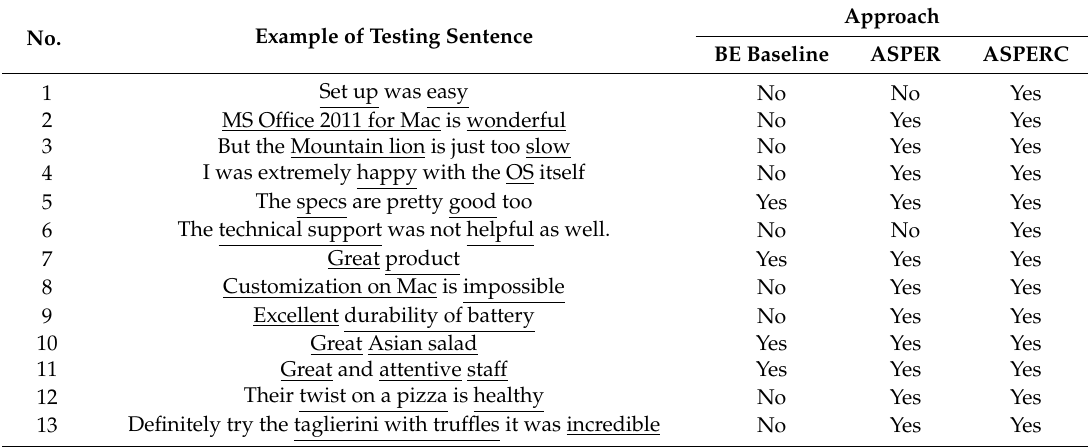
Table 13. Comparison of aspect-sentiment pair extraction ASPER model, ASPERC model, and BE baseline. No. Example of Testing Sentence